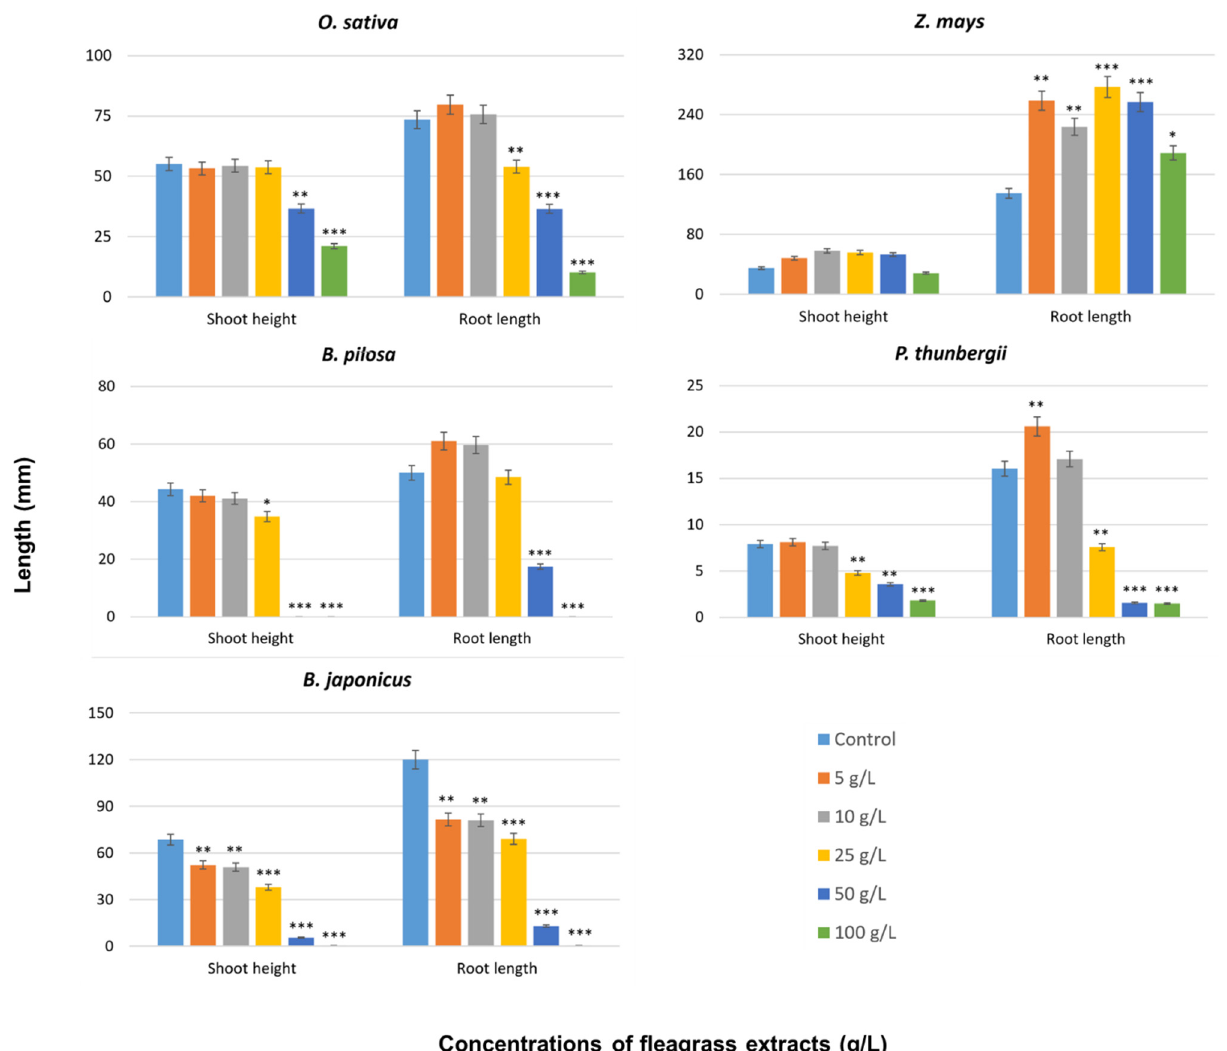
Figure 1. Effects of different concentrations of fleagrass extracts on shoot height and root length in five target plant species. The significant differences between treatments and control are indicated by asterisks: * p < 0.05, ** p < 0.01, and *** p < 0.001. Table 3. Response index of extracts from fleagrass aerial parts on the growth of five target plant species.